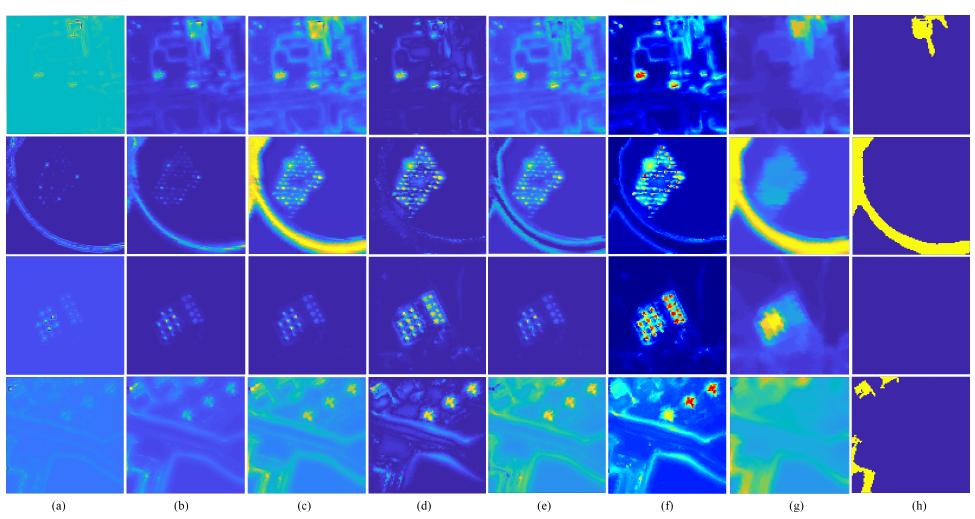
Figure 8. Detection maps of the four combination methods. The sample images from top to bottom are airport-1, beach-2, urban-2, and AVIRIS-1, respectively. ( a ) AD-WD; ( b ) AD-WD-GF; ( c ) adjusted detection map achieved by the exponential nonlinear function; ( d ) AD-WD-GF-TVCF; ( e ) AD-WD-GF- Maxtree; ( f ) AD-WDSF; ( g ) background information achieved by AD-WD-GF-TVCF; ( h ) background information achieved by